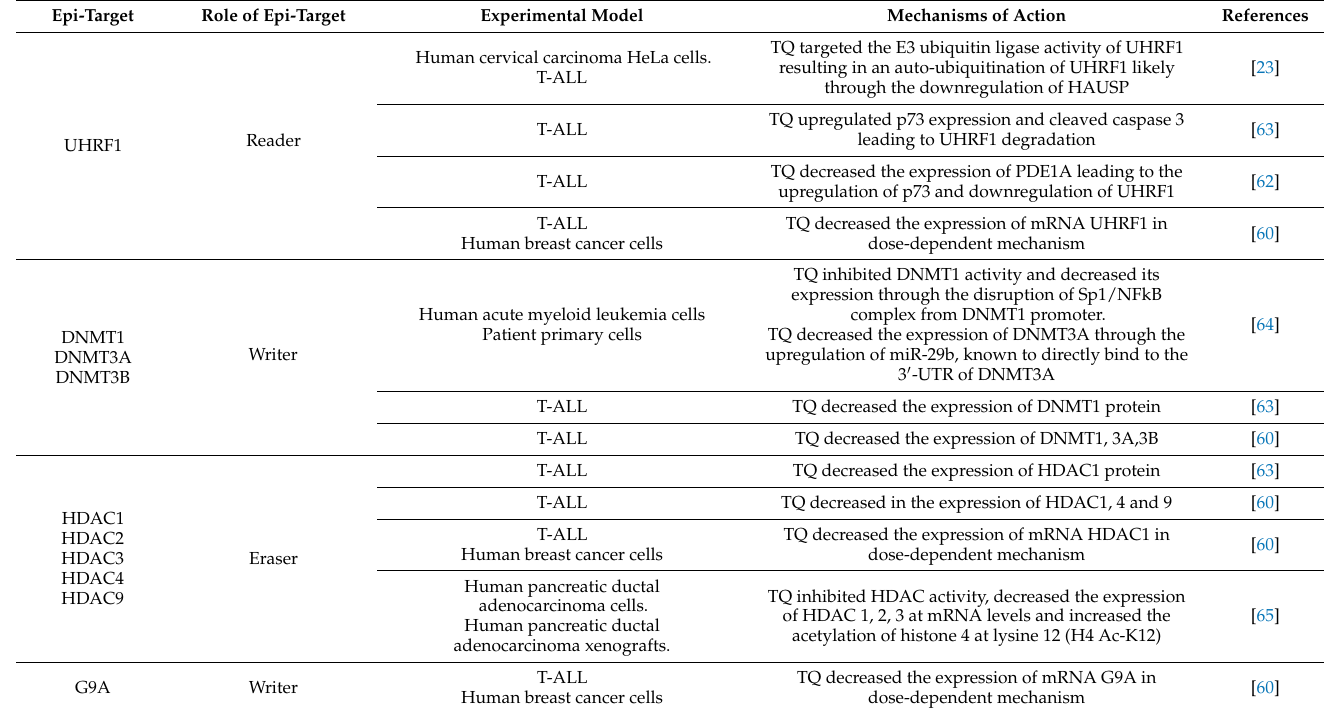
Table 1. Epigenetic targets of thymoquinone in